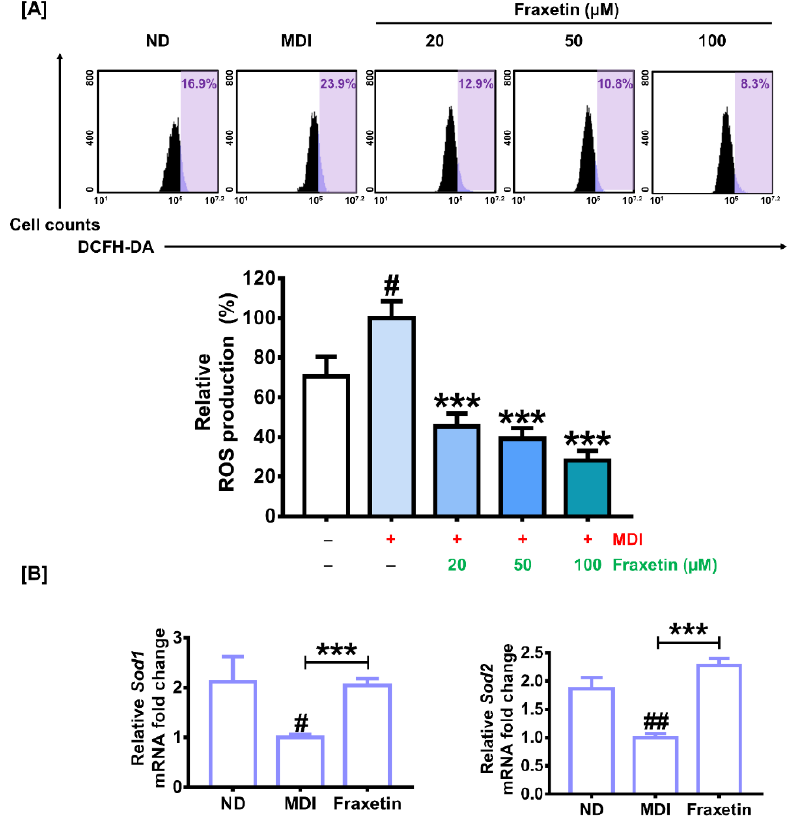
Figure 5. Effect of fraxetin on ROS production and the transcriptional expression of scavenging genes during the adipogenesis of 3T3-L1 cells. ( A ) ROS production was evaluated with DCFH-DA using flow cytometry. Relative ROS production is represented as purple shadow in a bar graph. The different colors in bar graph represent the different concentration of fraxetin. ( B ) The mRNA expres- sions of scavenging genes ( Sod1 , Sod2 ) were analyzed with RT-qPCR. Each gene was normalized with the GAPDH gene. All data were obtained in triplicate. The asterisk indicates significant differ- ences between the MDI-treated group and others (*** p < 0.001). The crosshatch symbol represents significant differences between the nondifferentiated group and others (# p < 0.05, ## p < 0.01), as verified using unpaired t -tests or one-way analysis of variance (ANOVA), followed by Dunnett’s post hoc analysis. 3.6. Fraxetin Suppresses Adipogenesis via the Regulation of MAPK Signaling